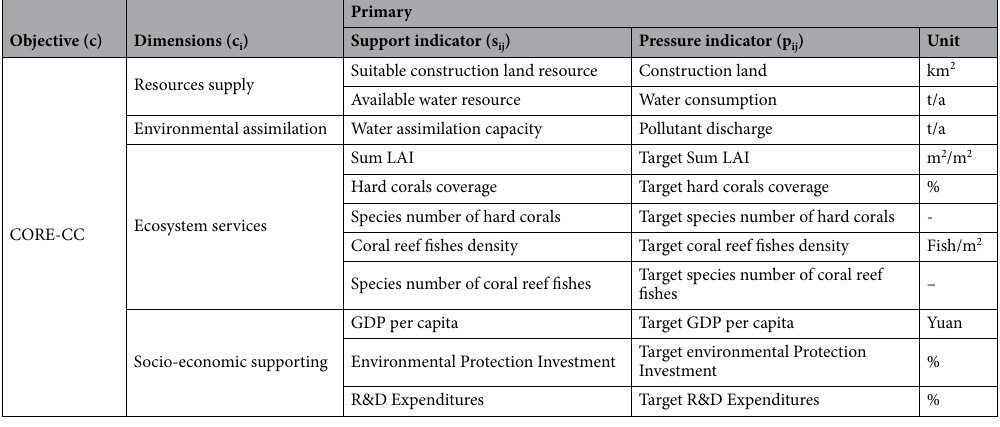
Table 3. Indicators system for